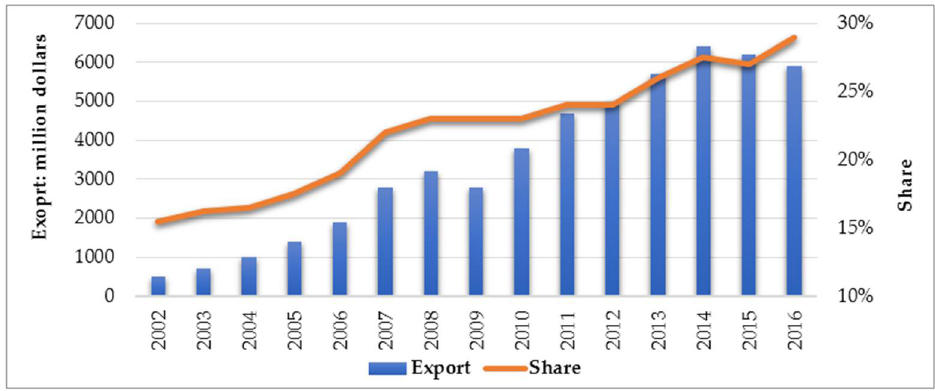
Figure 5. China’s exports to the B&R countries and the share of China’s total exports.